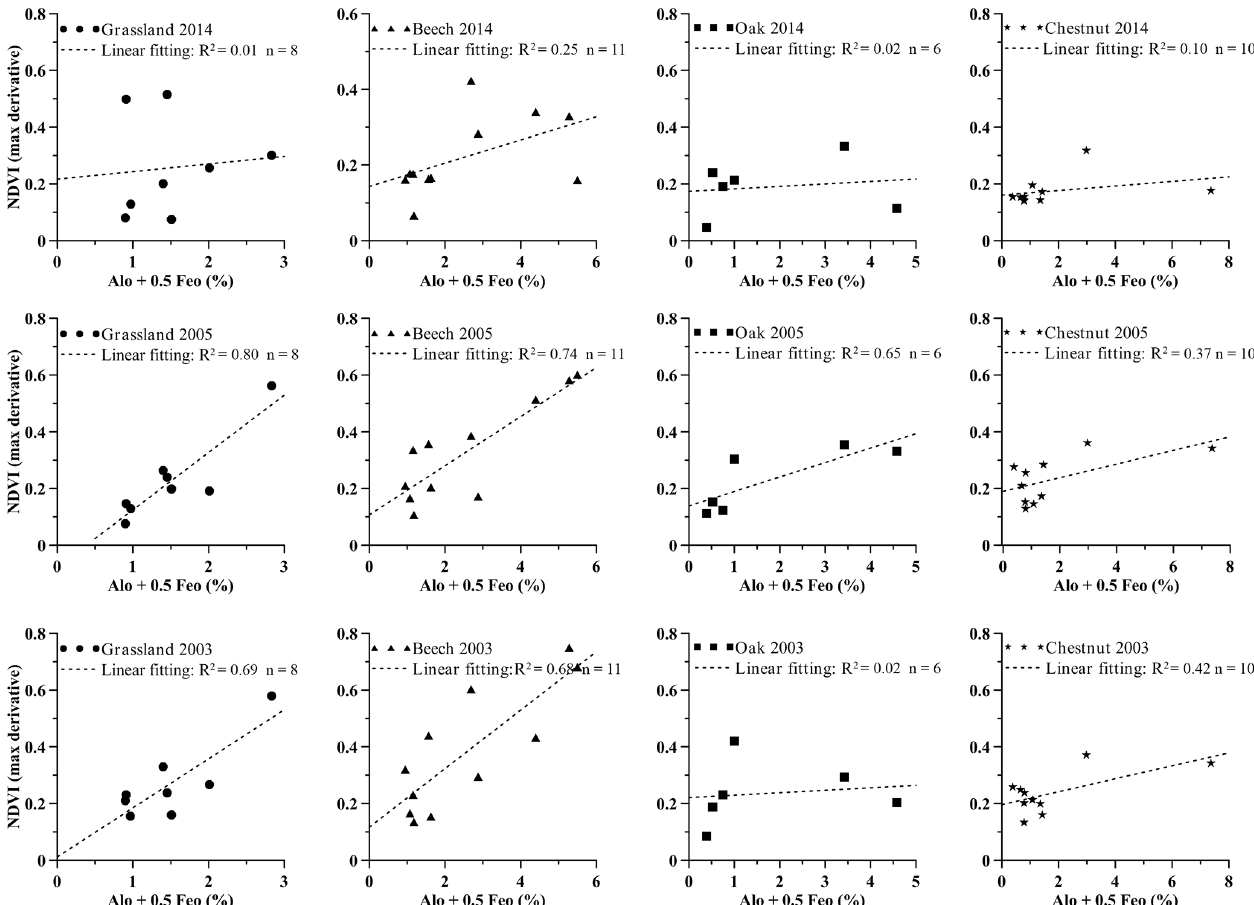
Figure 4. Scatterplot between Al o + 0 . 5Fe o index (weighted mean Al o + 0 . 5Fe o % according to horizon thickness for each of the studied pedons) and the maximum value of the NDVI derivative. From left to right: grassland, beech, oak, and chestnut. From bottom to top: year 2003, 2005, and 2014. The dashed lines show the linear regression for each land cover. Coefficient of determination R 2 along with data points ( n ) is reported for each